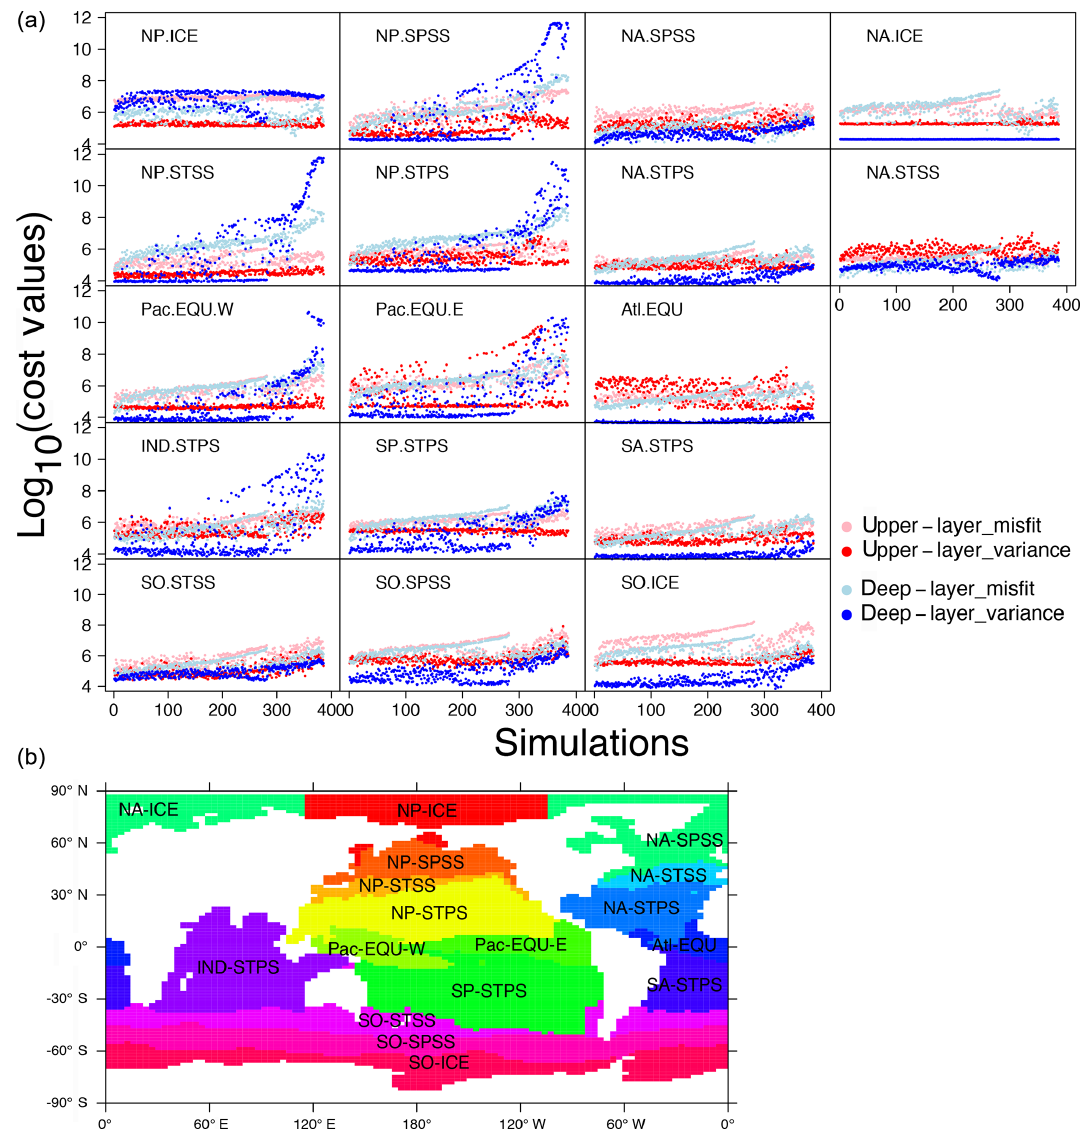
Figure 9. (a) Cost–value distributions in the 17 biomes in OPEM. The order of the simulations is based on the total cost from low to high in OPEM. The upper layer and deep layer in the legend represent upper (0–550m) and lower (below 550m) components of the cost function (Eq. 5). Misfit and variance are calculated by the first and second parts of the cost-function components (Eqs. 6 and 7), respectively. (b) Map of biome